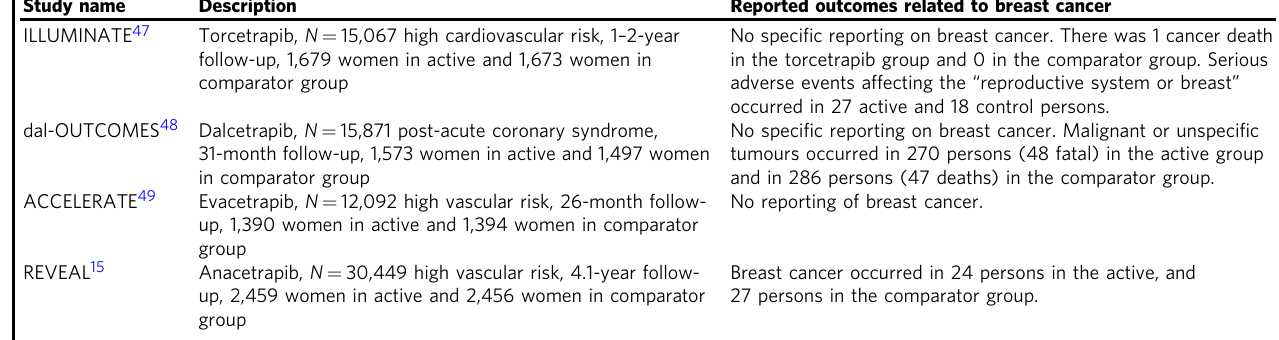
Table 1 Breast cancer outcomes in clinical trials of CETP